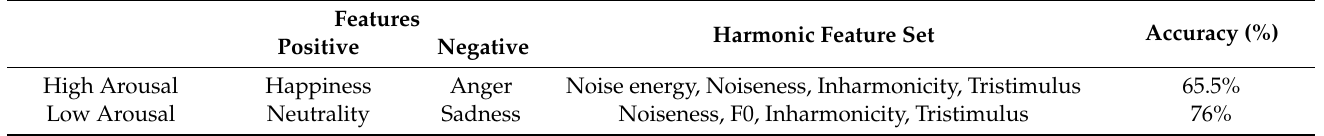
Table 2. Examples of sentences recorded for each